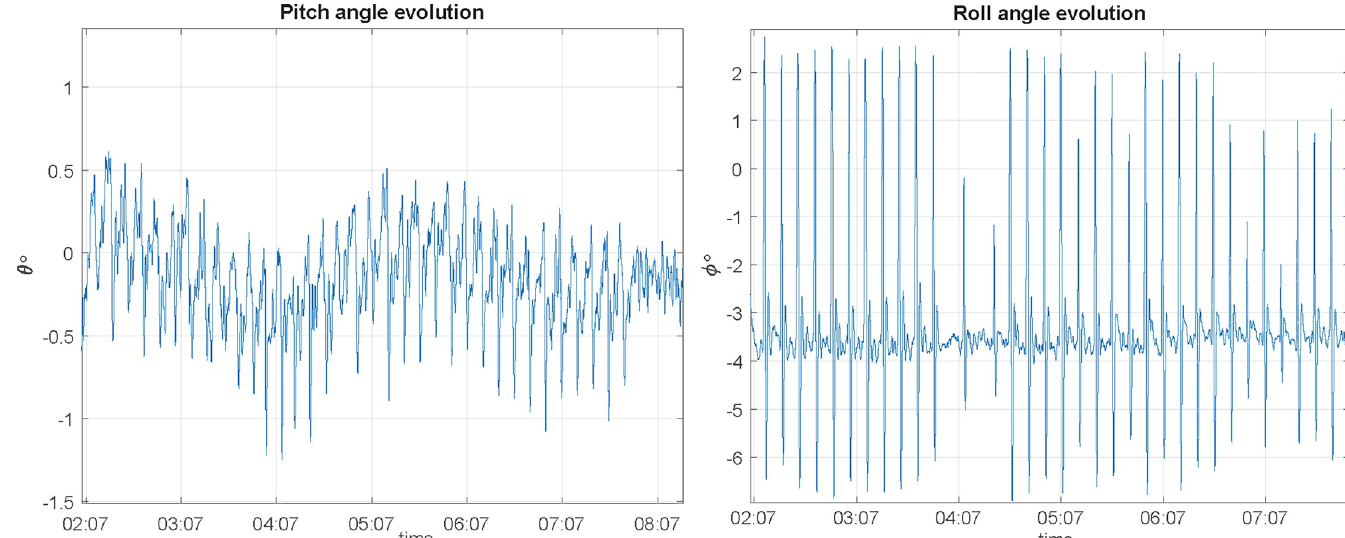
Fig 18. Pitch and roll angle evolution for a 10˚ polygonal flight at v = 1 m/s, radius 50